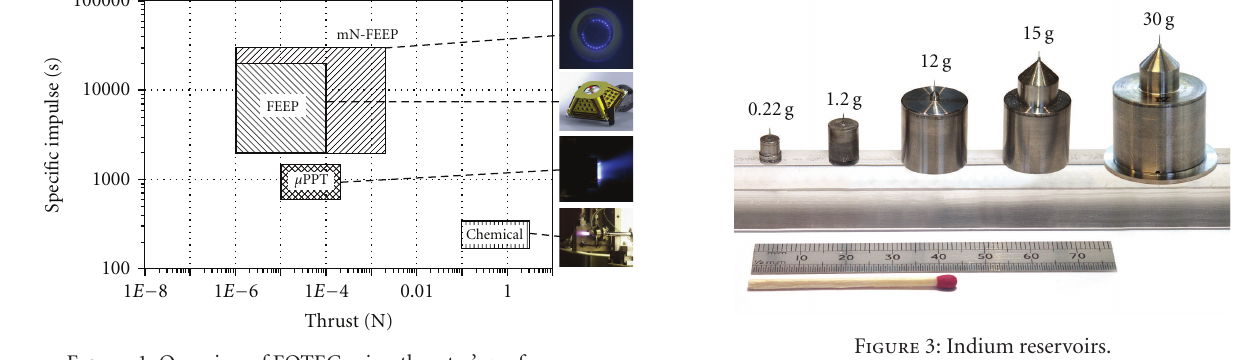
Figure 1: Overview of FOTEC microthruster’s performance.